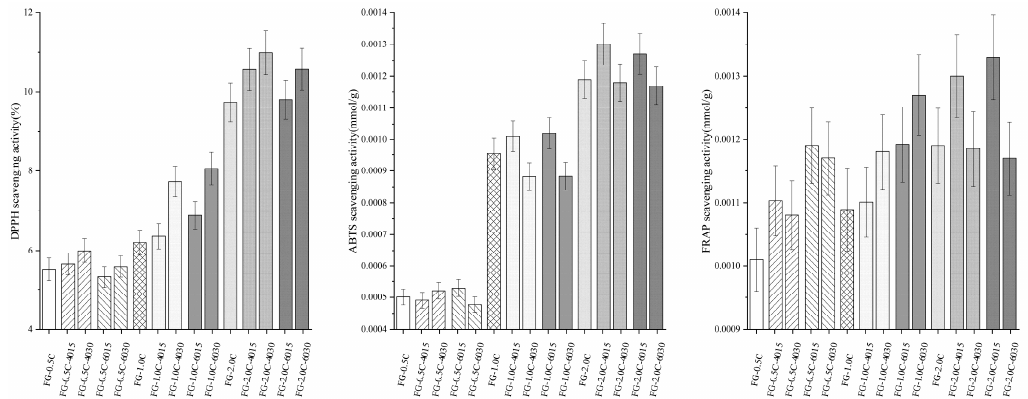
Figure 7. Effect of sonication on antioxidant activities of flaxseed gum films incorporated with carvacrol (The bars with the same pattern had the same carvacrol concentration and sonication power).